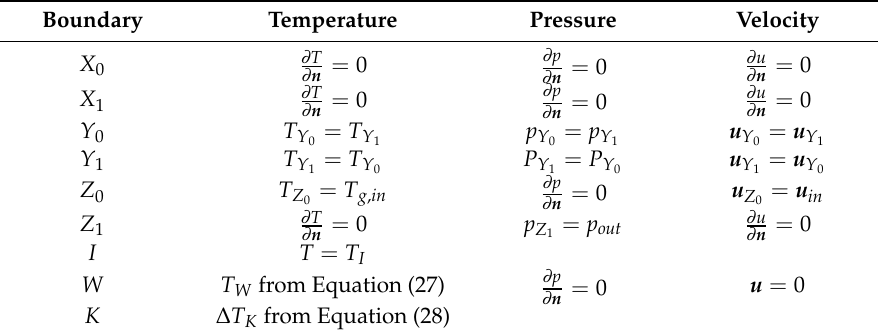
Table 1. Overview of the boundary conditions employed for the CFD analysis.